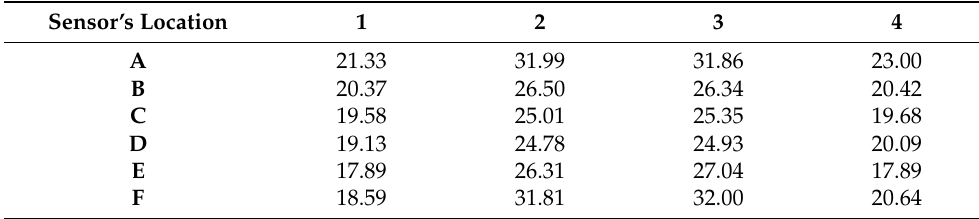
Table 2. Calculation of Mises stress in the hierarchical stiffened plate